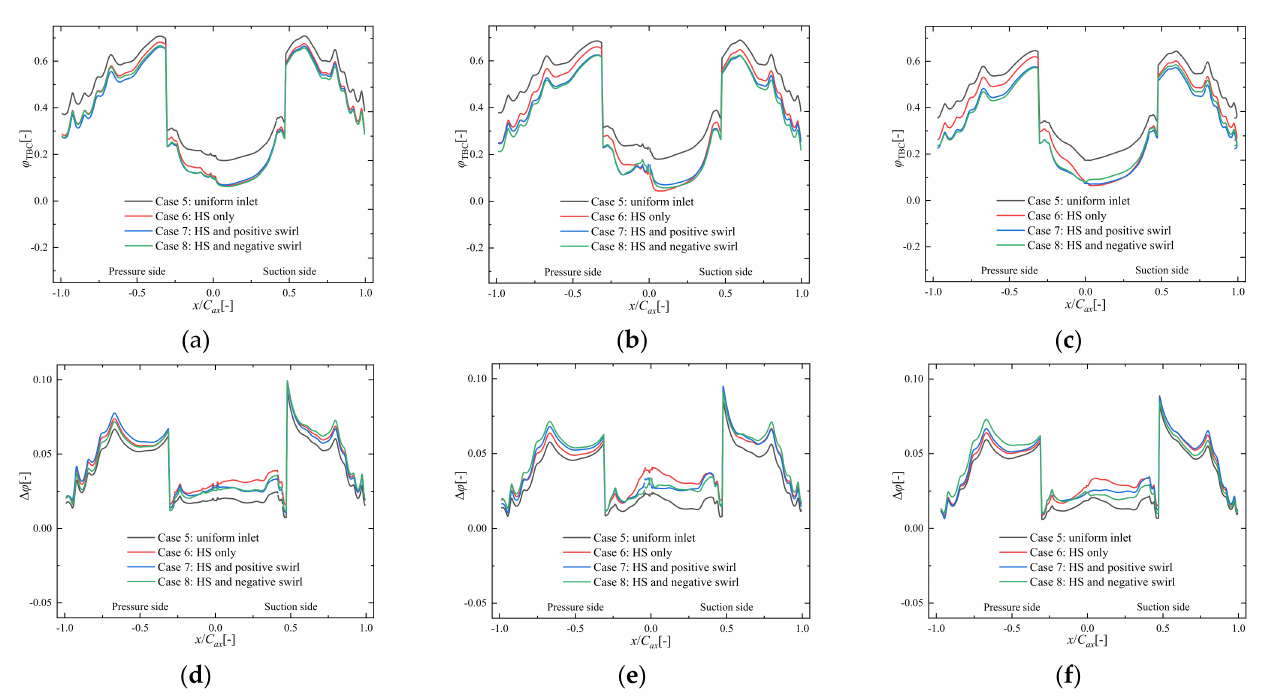
Figure 19. Cooling effectiveness and cooling effectiveness increment along the vane surface; ( a ) cooling effectiveness at z = 25% span; ( b ) cooling effectiveness at z = 50% span; ( c ) cooling effectiveness at z = 75% span; ( d ) cooling effectiveness increment at z = 25% span; ( e ) cooling effectiveness increment at z = 50% span; ( f ) cooling effectiveness increment at z = 75%